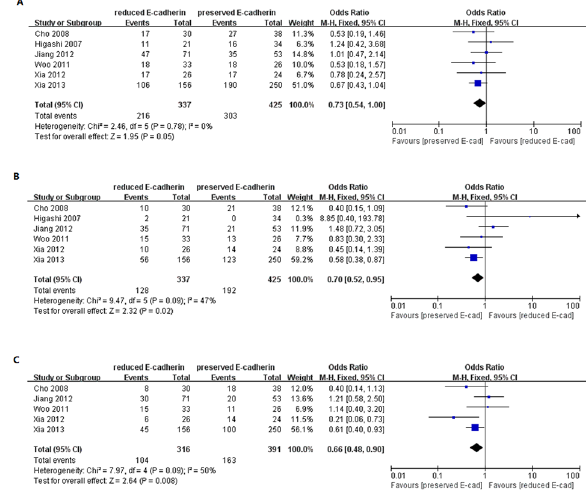
Figure 2. Forest plot displaying the results of the meta-analysis on 1-year (A), 3-year (B) and 5-year (C) overall survival.